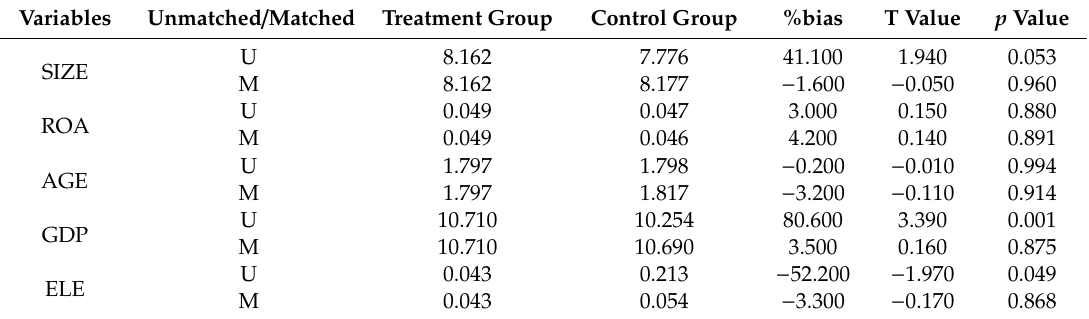
Table A1. Balance test.